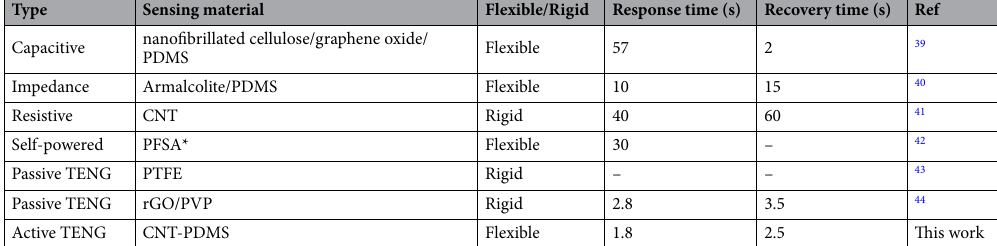
Table 1. Comparison of humidity sensing characteristics of similar previous investigations with our fabricated CNT-PDMS sensors. *perfluorosulfonic acid ionomer.